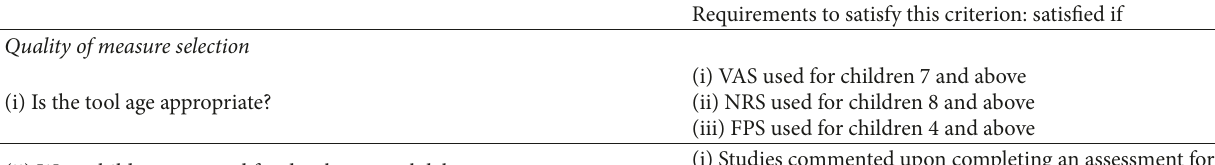
Table 1: Quality criteria and